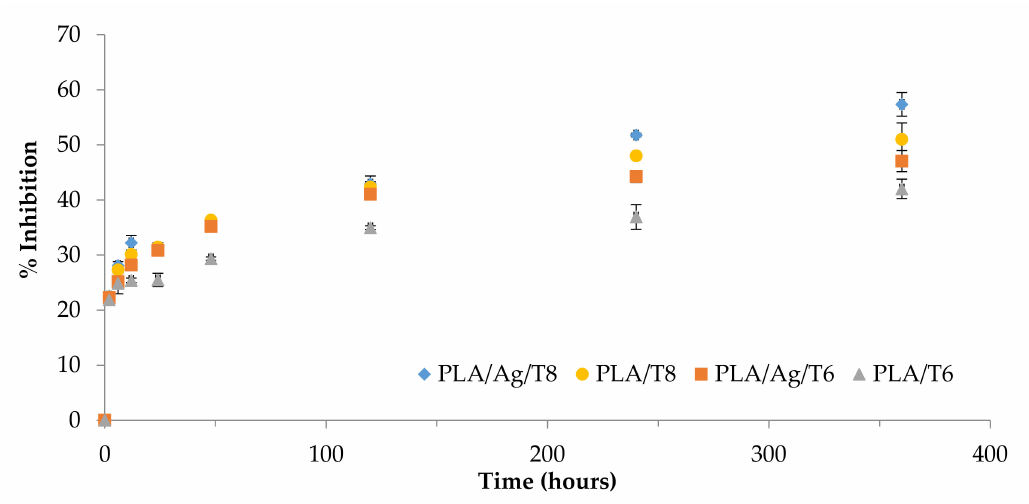
Figure 5. The 2-diphenyl-1-picrilhydrazyl (DPPH) reduction properties of thymol over